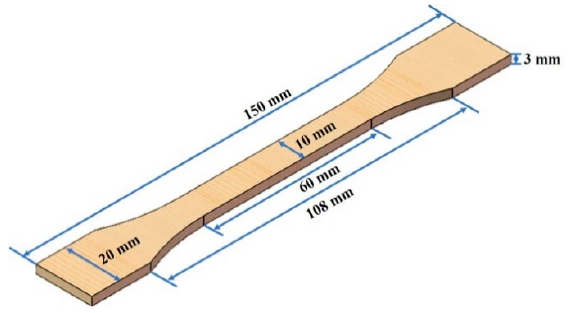
Figure 1. Dimensions of the test samples.